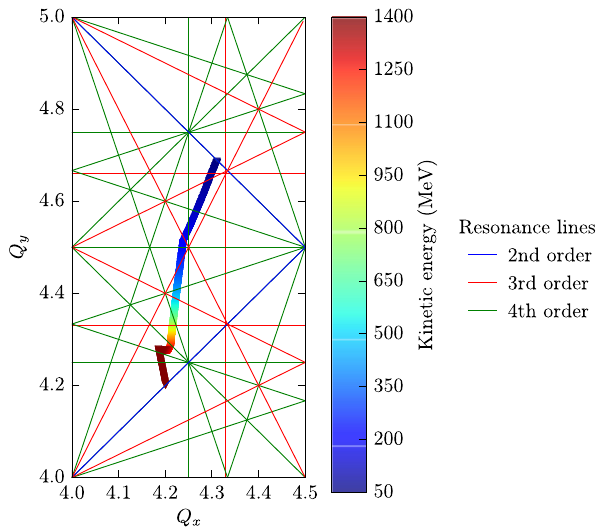
FIG. 1. Calculated zero-intensity working point evolution along the PSB cycle for the MTE beam. Injection takes place in the upper right end of the working point lines. Resonance lines up to 4th order are